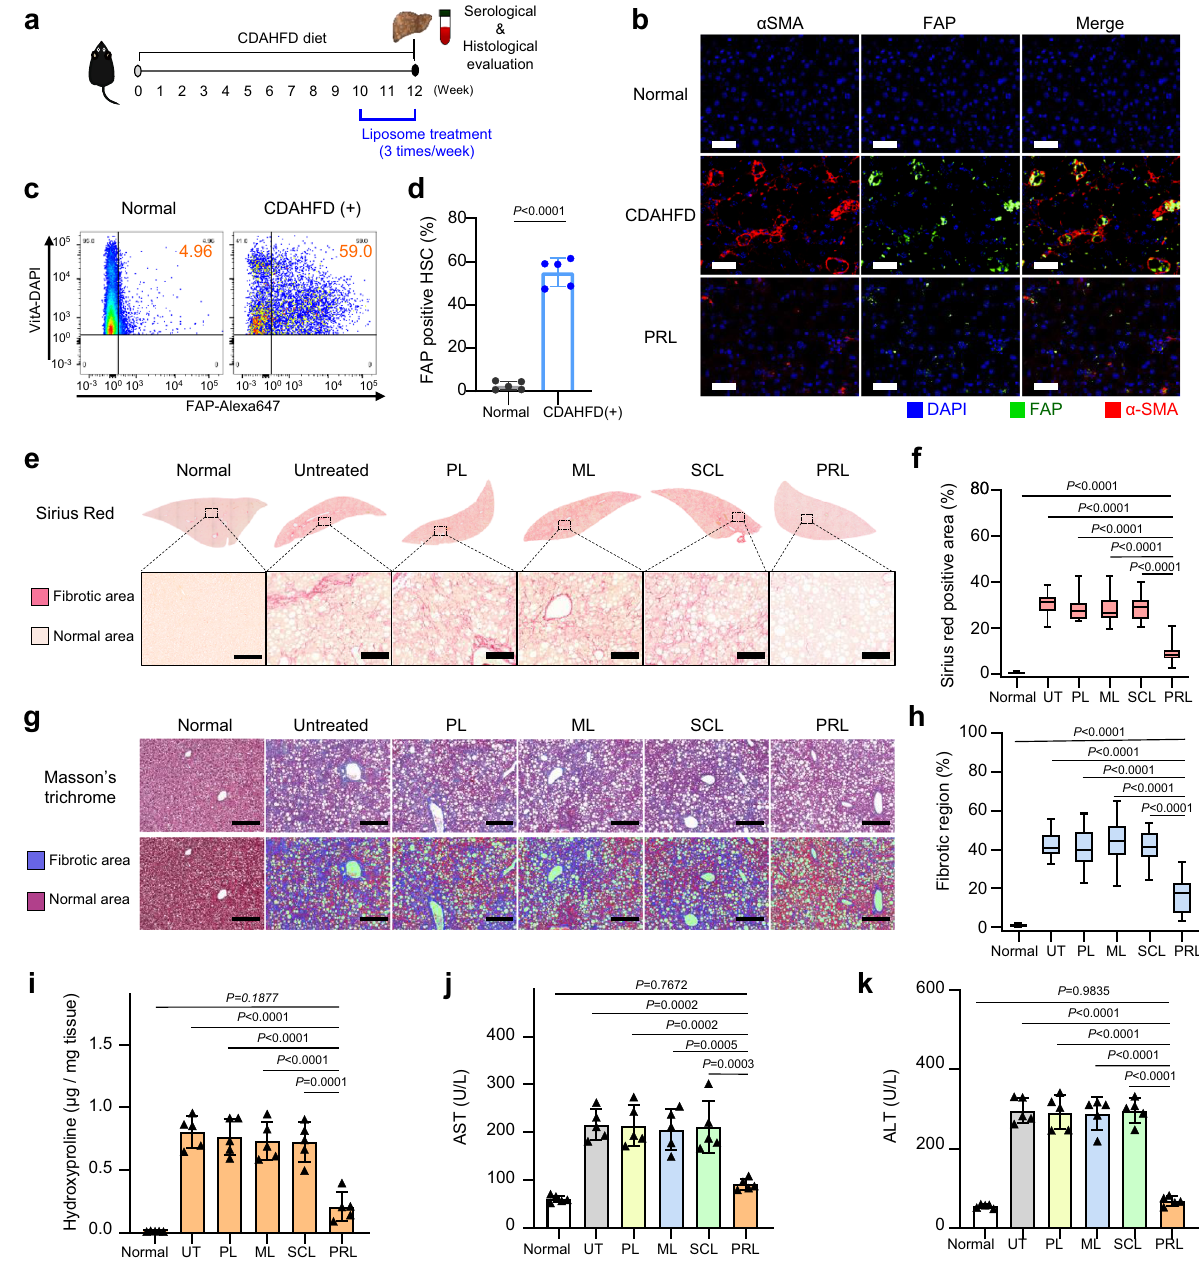
molar ratio of 2:2:2:0.4 in chloroform. For comparison, 1,2-distearoyl-sn-glycero-3- phosphoethanolamine-N-[(polyethylene glycol)-2000] (PEG-DSPE; Avanti Polar Lipids) was used in place of mal-PEG-DSPE in some experiments. After removal of chloroform using a rotary evaporator, the resulting thin lipid fi lms were hydrated with 1mL of phosphate-buffered saline (PBS; pH 7.4), vortexed, and extruded three times through 0.2 μ m polycarbonate membrane fi lters (Millipore Corp., Billerica, MA, USA). This process resulted ML or PL. The resulting ML were further used to prepare PRL. For preparation of PRL, 0.8 μ mol cys-promelittin (Peptron, Daejeon, Republic of Korea) was mixed with 1mL of ML containing 0.4 μ mol of mal-PEG- DSPE. The cysteine in the peptide was reacted with maleimide groups of ML by incubating at room temperature for 6h. NATURE COMMUNICATIONS| (2022) 13:1516